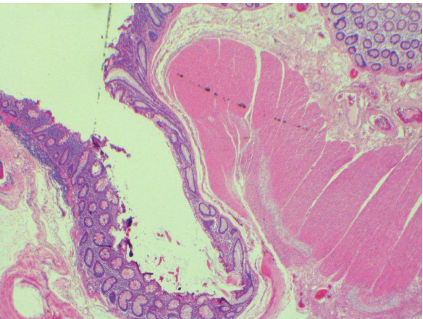
Figure 1: Section of caecal diverticulum showing the outpouching of mucosa and preservation of the muscularis propria excludeing